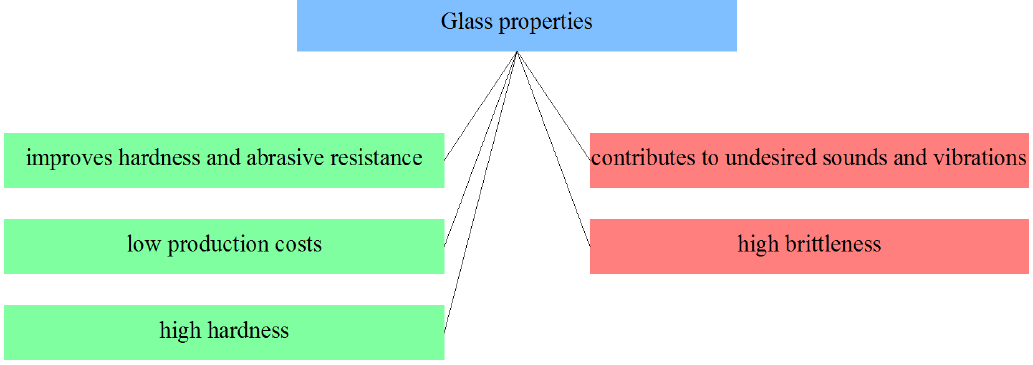
experiments, which was attributed to the higher static fric- tion due to the smooth surface. The friction materials with milled glass fibers, therefore, can have a higher propen- sity for friction-induced vibration during brake applica- tions [108]. It is also worth noting that glass has a high melting temperature (over 1400 ∘ C) and is a good thermal insulator [109]. While the former property is beneficial in brake pads as it stabilizes the coefficient of friction, the lat- ter one is rather avoided.